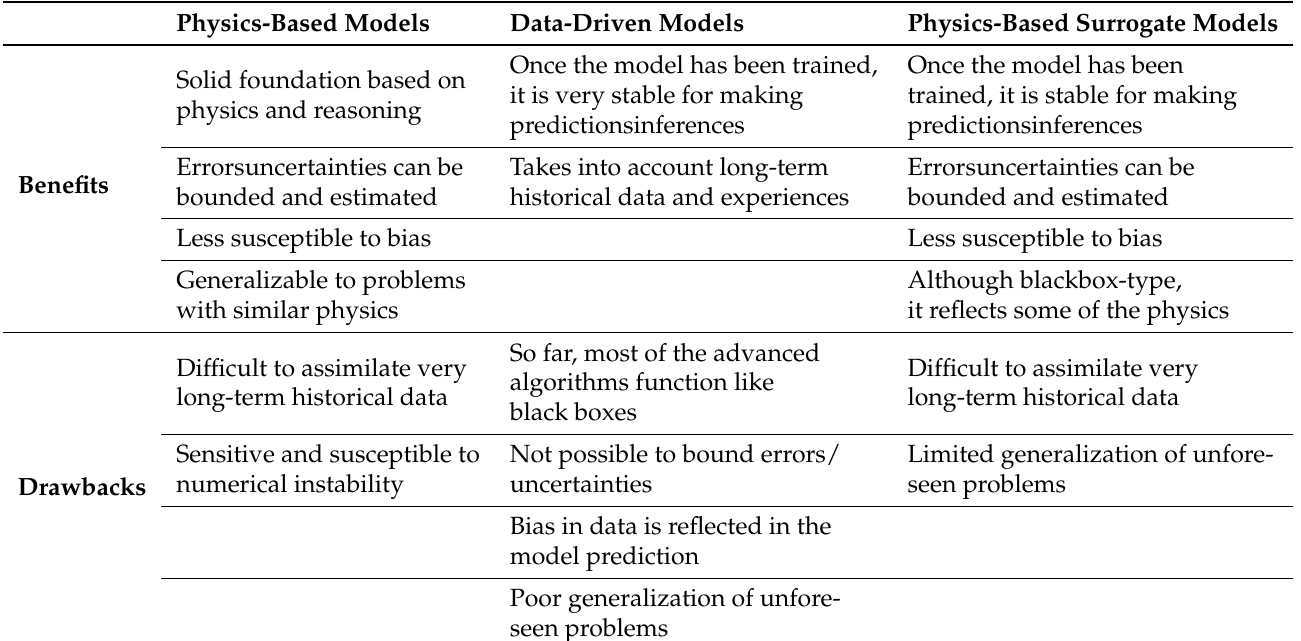
Table 3. Comparison of physics-based modelling, data-driven modelling and physics-based surrogate models (based on [6]). Physics-Based